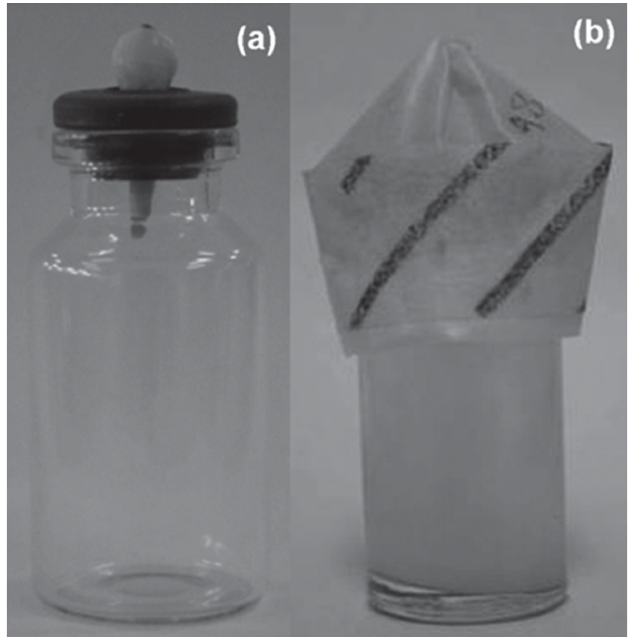
Fig. 1. Experiment preparation. (A) Experimental system; (B) Turbidity of the medium indicating bacterial growth.